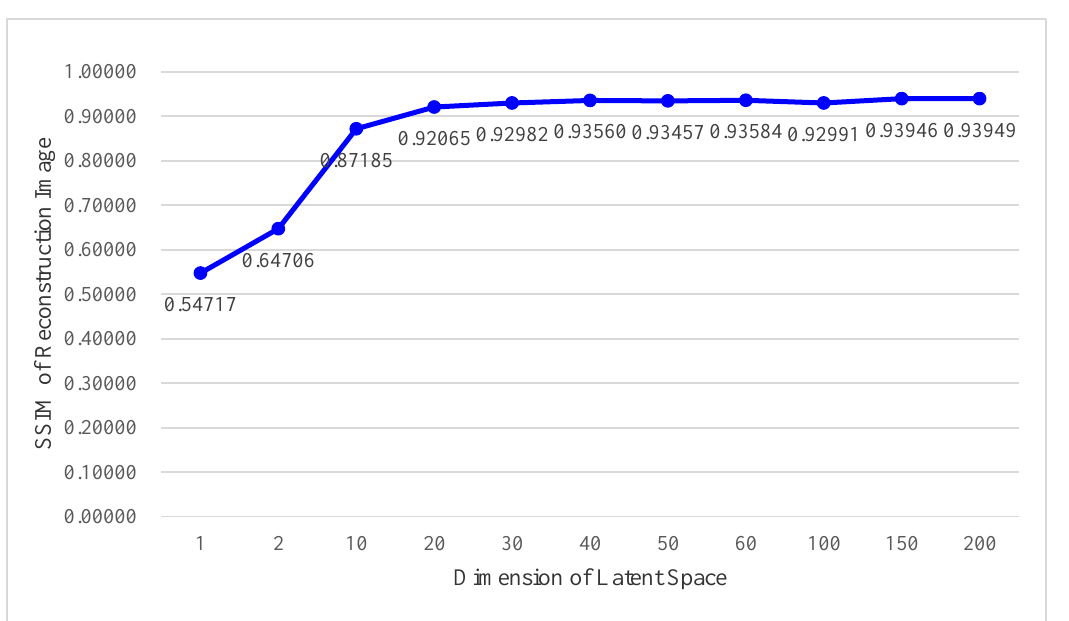
Figure 1. Data reconstruction performance using AAE.